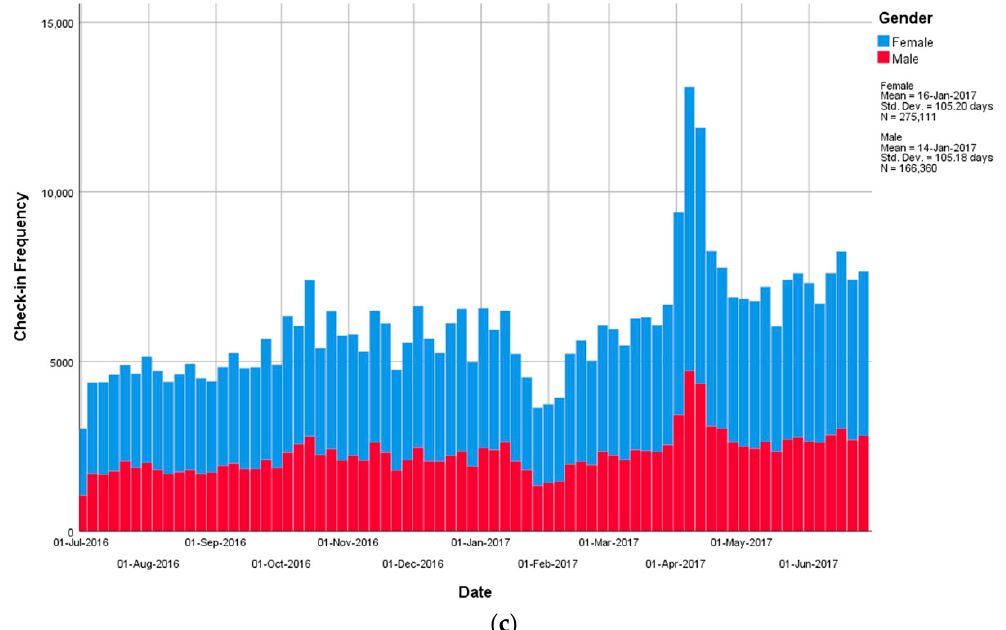
Figure 3. Check-in frequencies; ( a ) hourly check-in frequency; ( b ) weekly check-in frequency; and ( c ) check-in frequency for study period.